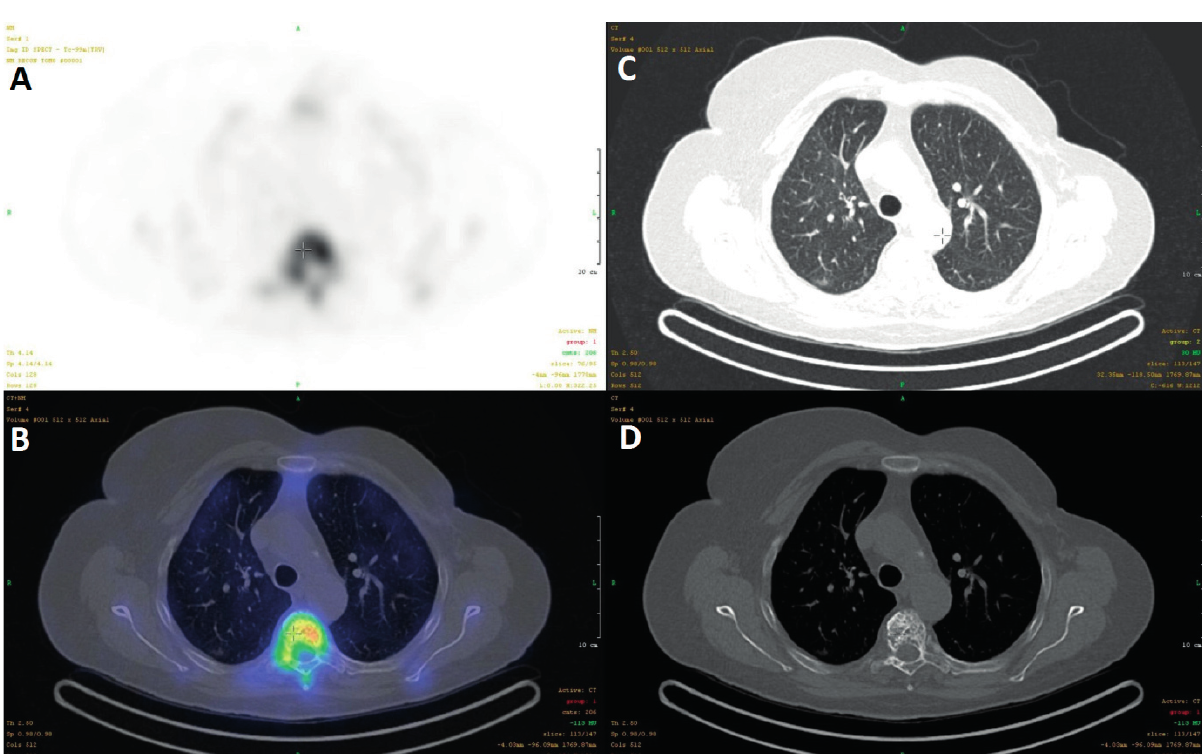
Fig. 3. Bone and lung window in evaluating the fused image with a mixture of metastases in the spine. (A) SPECT image, (B) fused SPECT/CT image, (C) CT image, lung window, (D) CT image bone